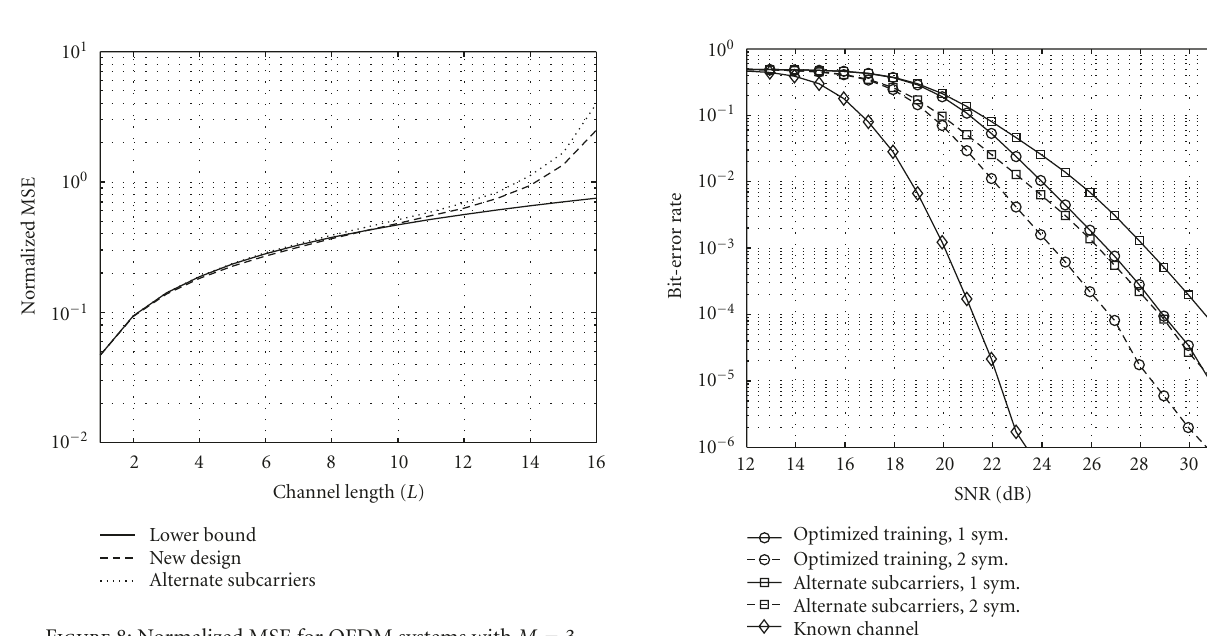
Figure 8: Normalized MSE for OFDM systems with M = 3.